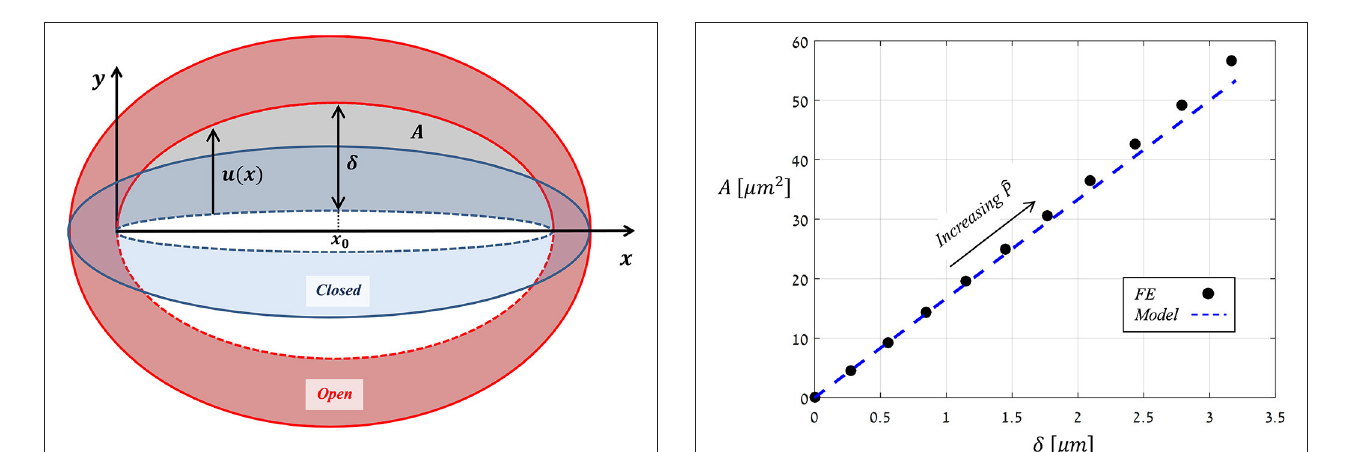
10), and theoretical modeling =